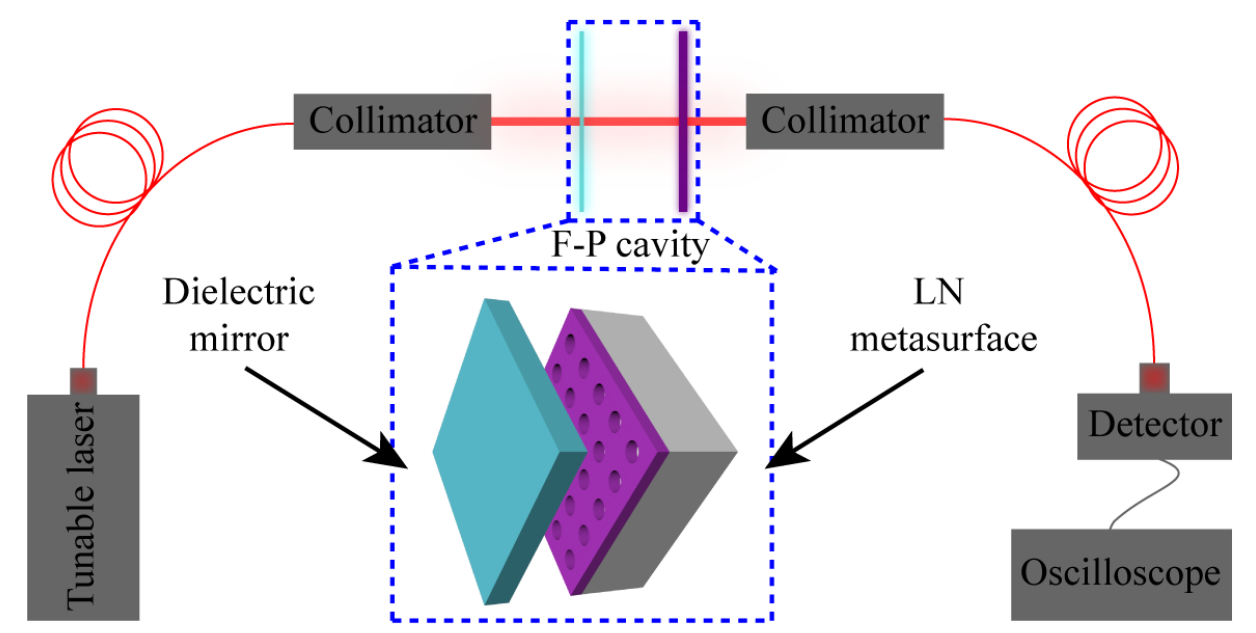
Figure 6. The F-P cavity and its measurement optical path. The F-P cavity is formed by the LN metasurface and another dielectric mirror with reflectivity close to 1.